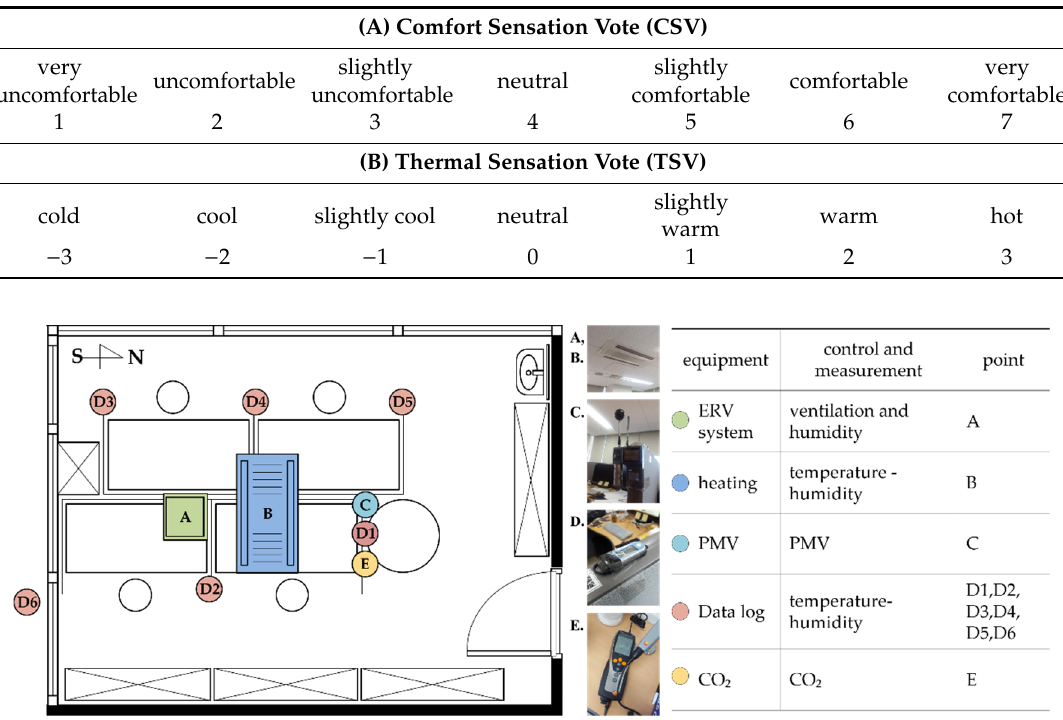
Table 2. Questionnaire survey items and evaluation.